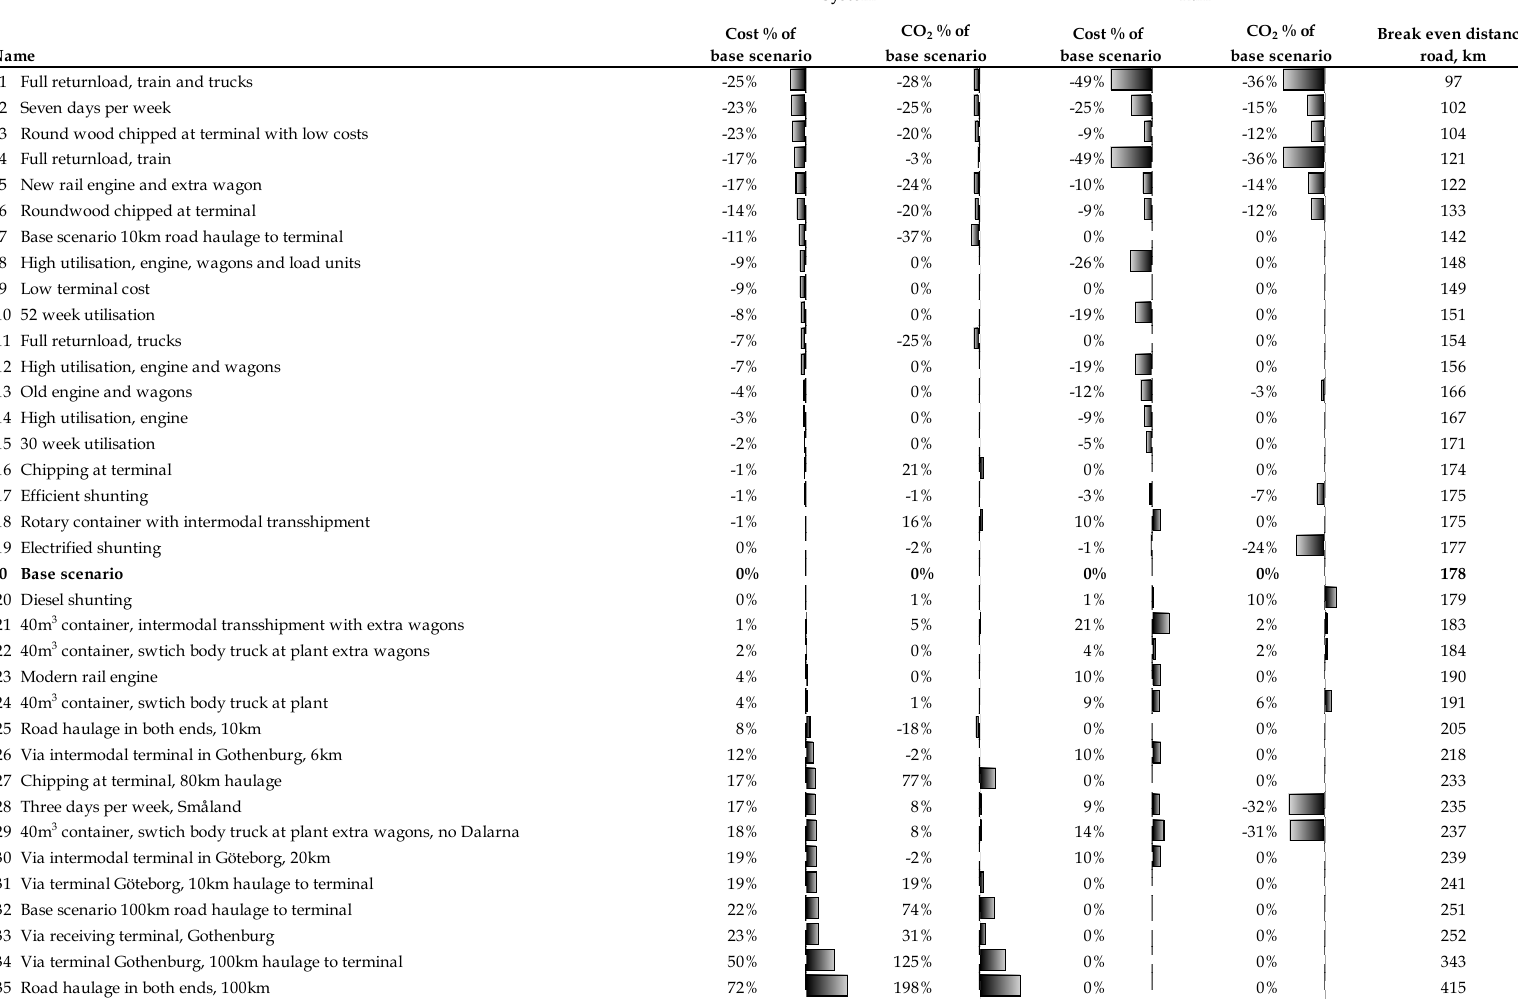
Table 3. Summary of